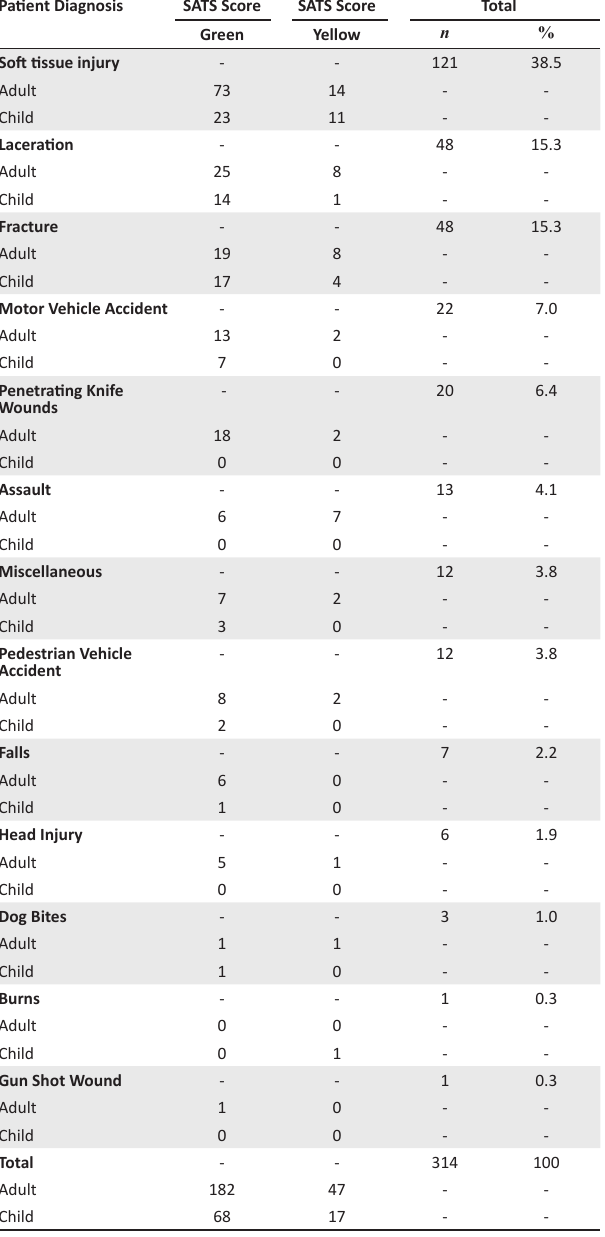
TABLE 2: Analgesia prescribed by healthcare professionals working in the referral clinics.